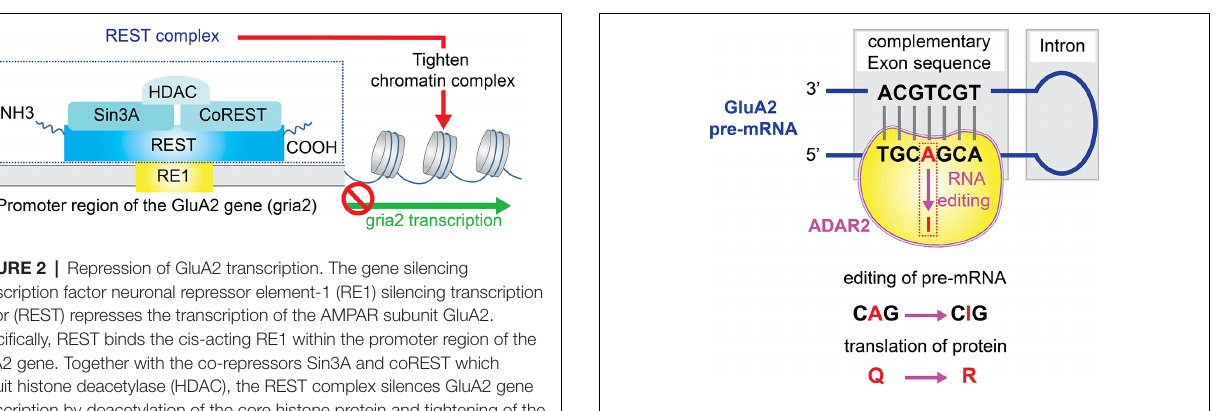
machinery ADAR2 binds to the double strands of GluA2 pre-mRNA, and catalyzes A-to-I conversion at the GluA2 glutamine/arginine (Q/R)